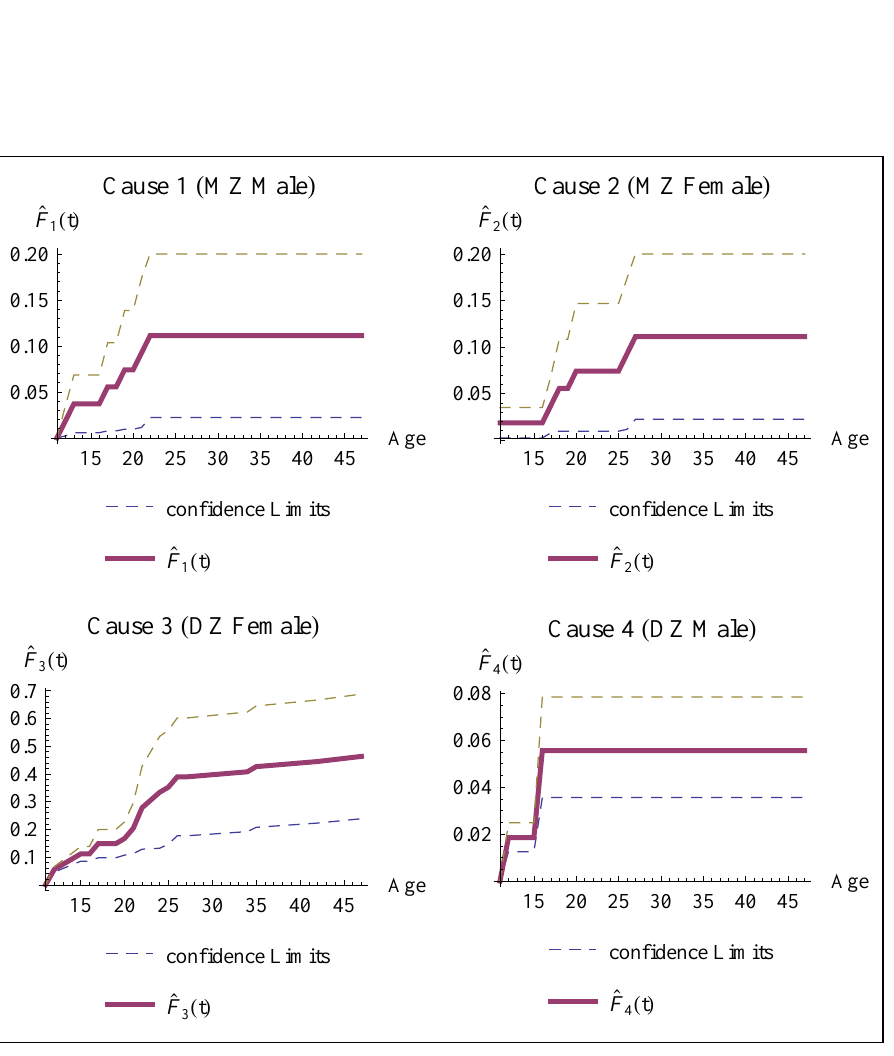
Figure 3 { Plot of estimate of F j ( t ); j = 1 , 2 , 3 , 4 for Australian twin